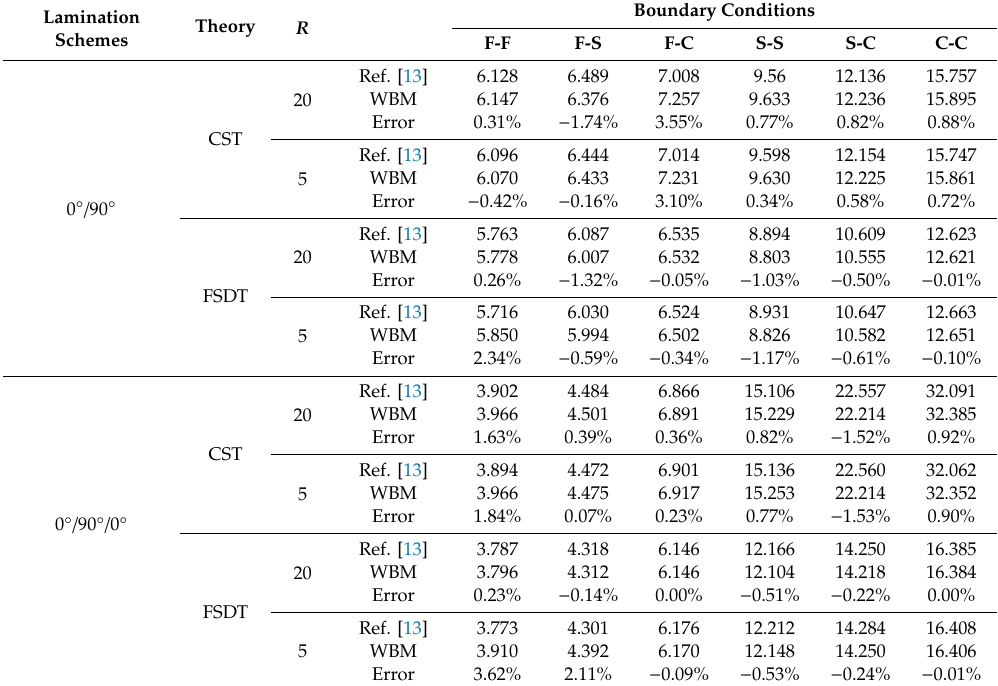
Table 5. The fundamental frequency parameter Ω for two types of the layered composite shallow cylindrical shell with various boundary conditions, theories, and radii.